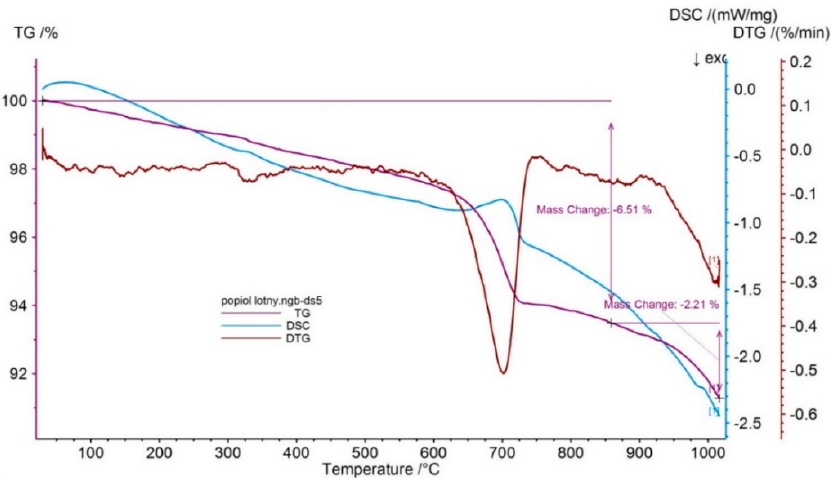
Figure 2. TGA-DTA thermogram for fly ash.